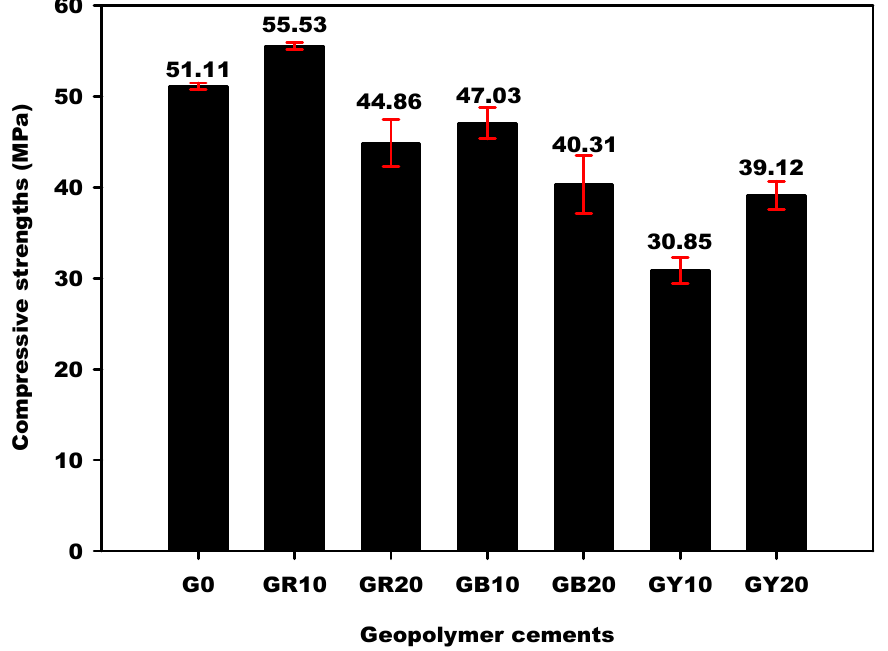
Figure 15. Compressive strengths of geopolymer materials.